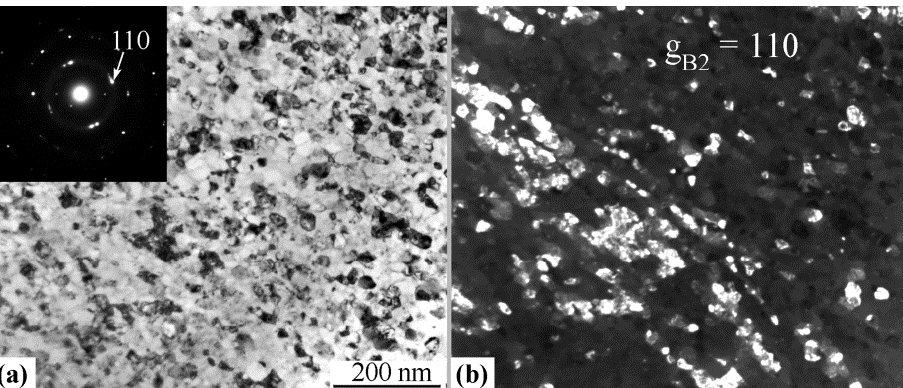
Figure 2. The mixed grain – subgrain structure of ab initio sample: ( a ) bright-field image (BF) and selection area electron diffraction pattern (SAED) obtained from an area with a diameter of Ds = 1.2 µ m; ( b ) dark-field image (DF) in B2; reflection {110} indicated by arrows on ( a ). The average grain/subgrain size was 80 nm. Similar substructure of NC TiNi alloys occurs because of polygonization of a dislocation structure that emerges at a moderate degree of deformation during cold rolling. In this case, nanograins are formed in the course of plastic deformation or as the result of crystallization of amorphized material [22,23].